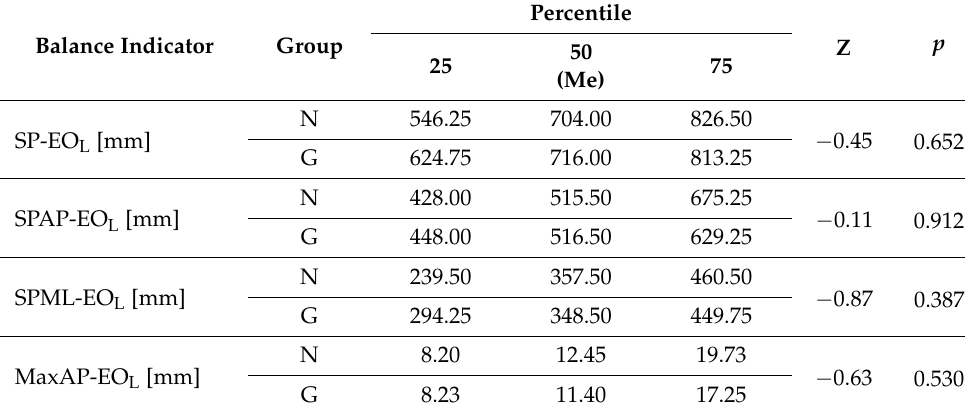
Table 2. Comparison of balance indicator values in tandem stance position with open eyes low (EO L ) between gymnasts and non-training